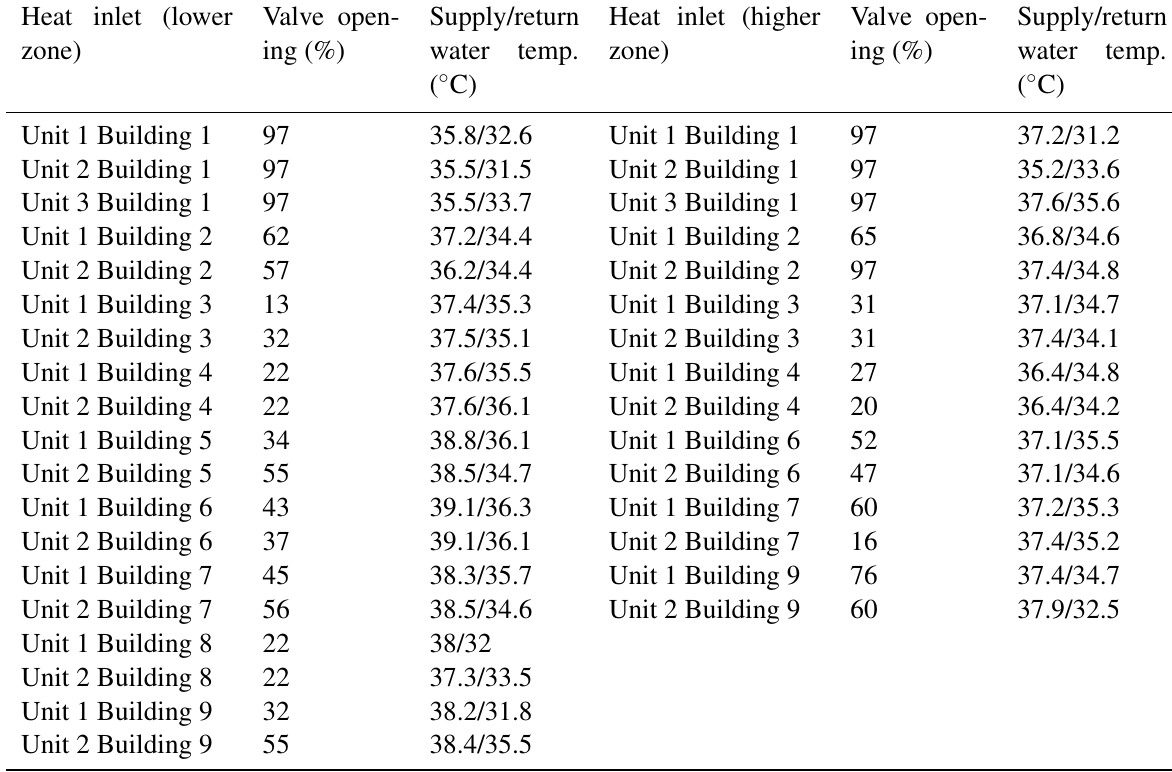
Table 3 Valve opening and supply and return water temperature at heat inlet of each unit before